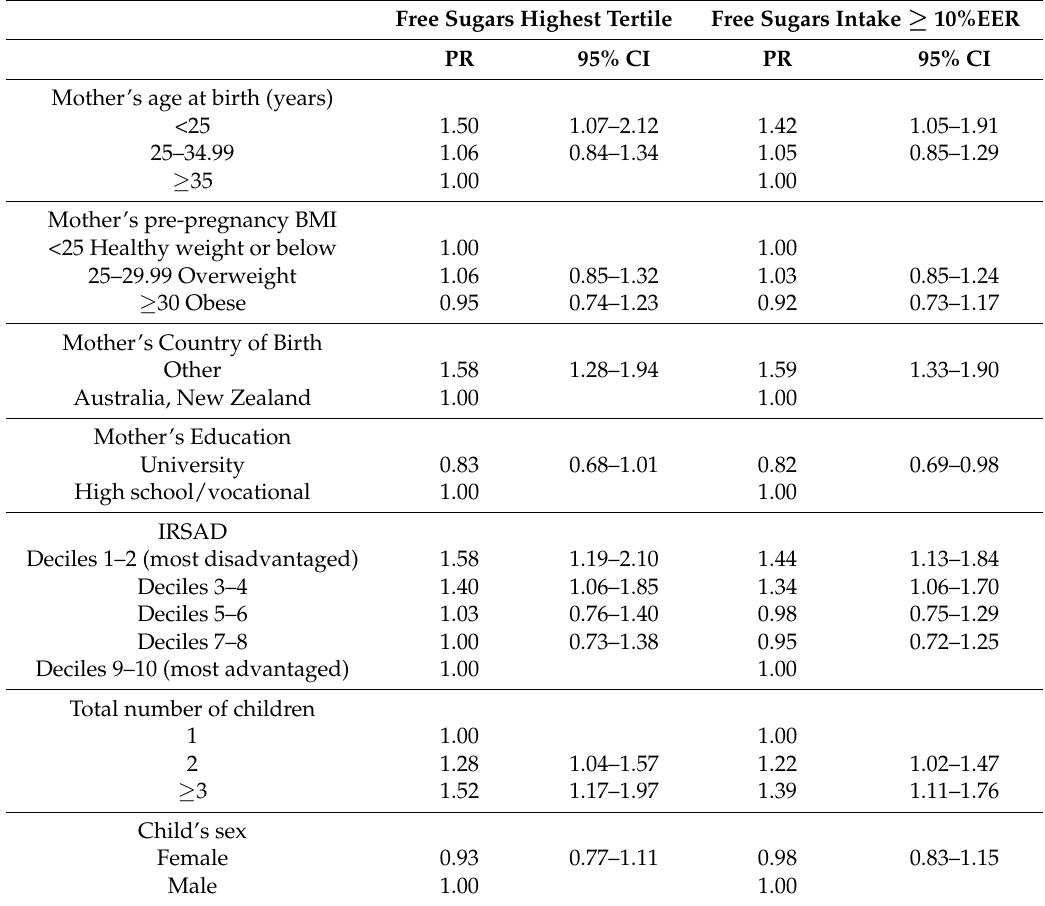
Table 5. Participant characteristics associated with high consumption of free sugars at 2 years ( n =